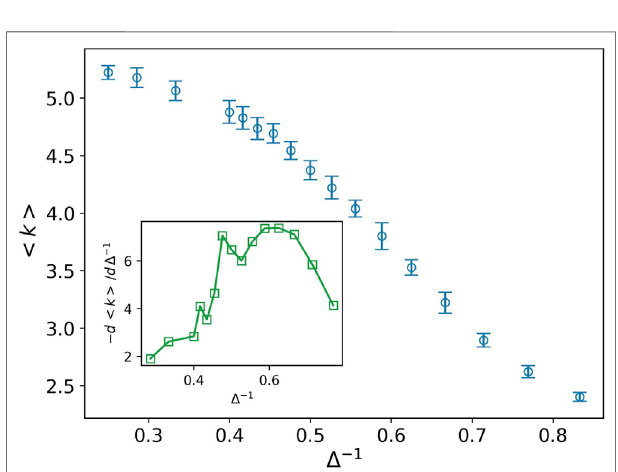
FIGURE 5 | Average degree (blue circle) against the inverse of attraction strength,and the attraction range has a fi xedvalue, σ = 1.5. The errorbars are the standard deviation of sampling over 20 simulation runs. Two peaks are observed at almost the same points which we predict as the solid – liquid and liquid – gas transitions (see inset plot).